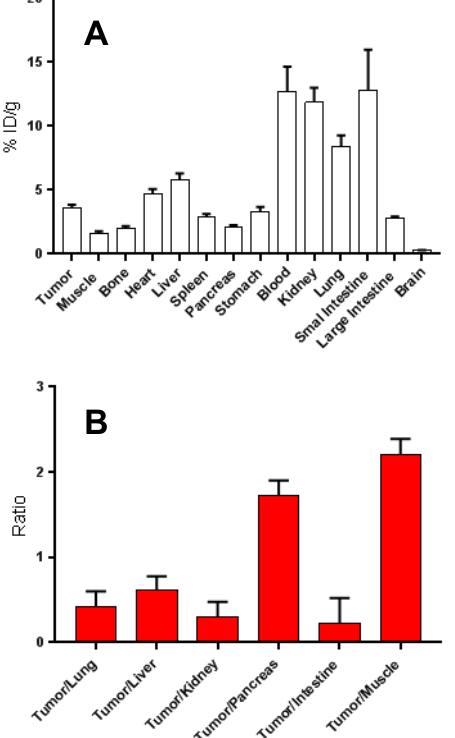
Figure 8. Representative microcoronal-PET/CT scans of HT29 colorectal tumour bearing mouse at 60 min ( A ) and 120 min ( B ) post i.p. injection of ca. 37 MBq of 68 Ga-DOTA-C21.